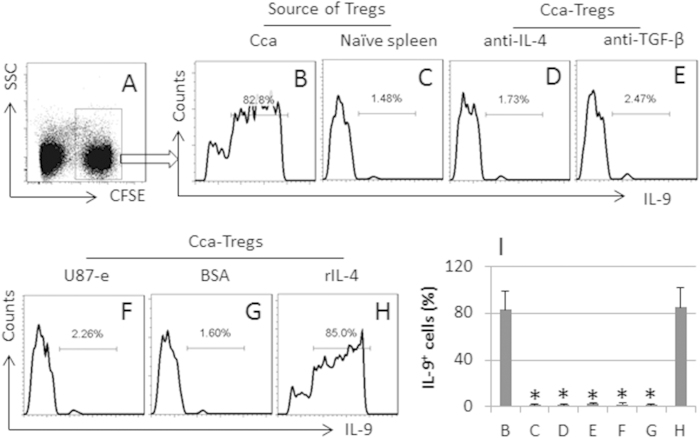
Cca-specific Th2 response converts intra-Cca Tregs to Th9 cells.CD4+ CD25+ CD127+ T cells and DCs were isolated from mice sensitized to Cca-e or U87-e. Intra-Cca Tregs were isolated from Cca-tissue and labeled with CFSE. CD4+ T cells and Tregs were cultured at a ratio of 1:1 in the presence of DCs, Cca-e (or U87-e, or BSA) (10 μg/ml) and IL-2 (10 ng/ml) for 10 days. The additional treatment is denoted above each subpanel. The cells were collected and stained with an anti-IL-9 antibody, and analyzed by flow cytometry. A, the gated dot plots indicate CFSE+ cells. B–H, the histograms indicate the frequency of IL-9+ cells in the gated cells of A. I, the bars indicate the summarized data of B–H. The data of bars are presented as mean ± SD. *, p < 0.01, compared with group B. Each group consists of 10 mice. The data are representatives of 10 independent experiments.